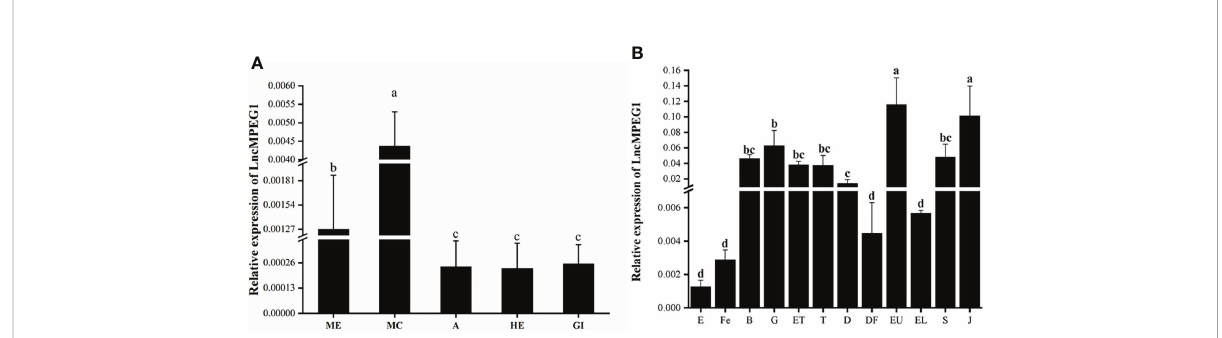
FIGURE 3 The normal expression pro fi le of LncMPEG1 in the different tissues (A) and at different development stages (B) of P. (f.) martensii . a: ME, mantle edge; MC, mantle center; A, adductor muscle; HE, hepatopancreas; and Gi, gill. b: the expression pattern of LncMPEG1 during the larvae development of P. f. martensii . E, egg; Fe, fertilized ovum; B, blastocyst; G, gastrula; ET, early trochelminth larva; T, trochelminth larva, D, D- stage larvae; DF, D-stage larvae prior to feeding; EU, early umbo larvae; EL, eyed larvae; S, spat; and J, juvenile; different letters indicate signi fi cant differences (P < 0.05).